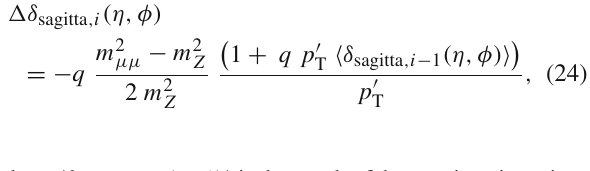
Table 4 Event selection criteria for Z → μ + μ − (Sect. 6.1.1) and Z → e + e − (Sect. 6.1.2) candidate events for the analyses of the sagitta biasesindata.Eventstriggeredbythelowest-thresholdunprescaledsin- gleanddoubleelectronandmuontriggersareusedtoselect Z → μ + μ −